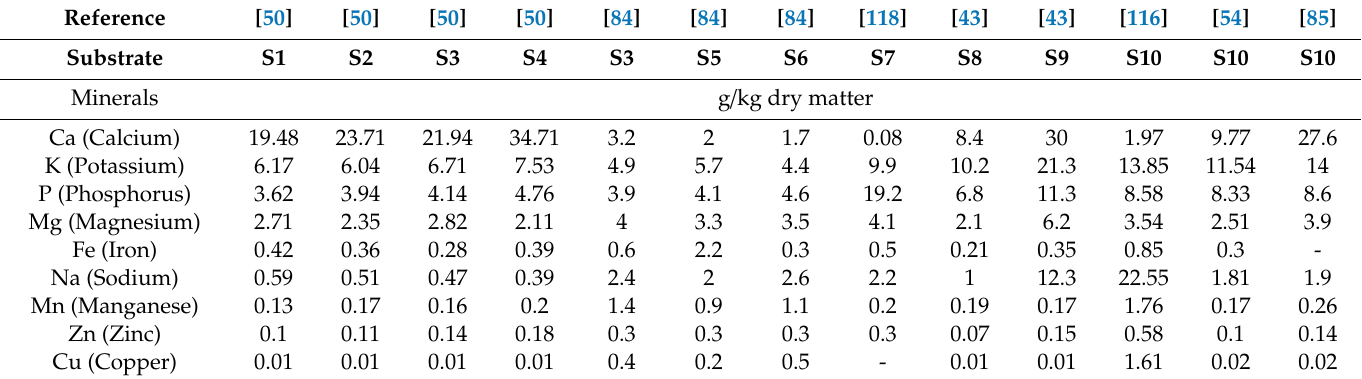
Table 5. Mineral content of BSFL reared on di ff erent